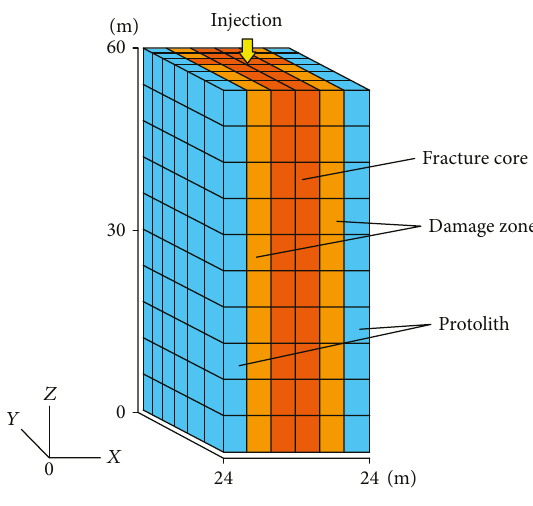
Figure 6: Numerical